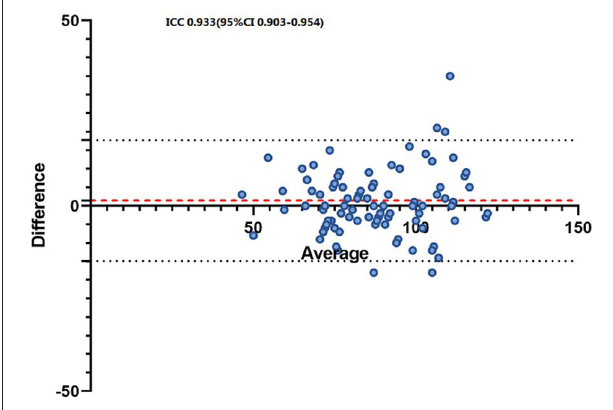
FIGURE 4 | Bland-Altman plots of the heart ratio between the ECG and AMAZFIT ®